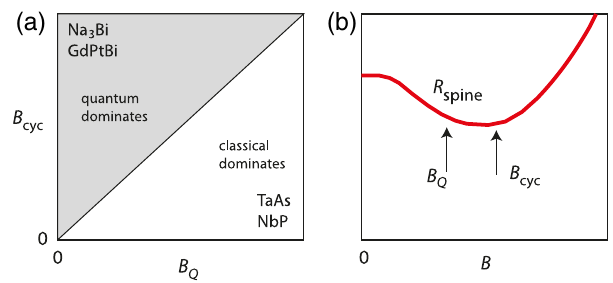
FIG. 5. Competition between the intrinsic chiral-anomaly LMR (with onset field B Q ) and the extrinsic classical effect of current ¼ A = μ , A ¼ 5 – 10 ). Panel (a): In the jetting (onset field B cyc shaded upper-half region, the system enters the LLL before the current-jetting effects dominate as B increases ( B Q < B ). Panel cyc (b) shows a hypothetical case close to the boundary B Q ≃ B . In cyc the profile of R , an initial decrease is followed by a steep spine increase above B . For systems in the unshaded region cyc ( B Q > B ), the LLL is entered long after current-jetting effects cyc become dominant. The classical effect effectively screens the quantum behavior. Bulk crystals of Na 3 Bi and GdPtBi fall safely in the upper half, whereas TaAs and NbAs fall in the lower half. One way to avoid current jetting in the latter is to lower B Q by gating ultrathin-film